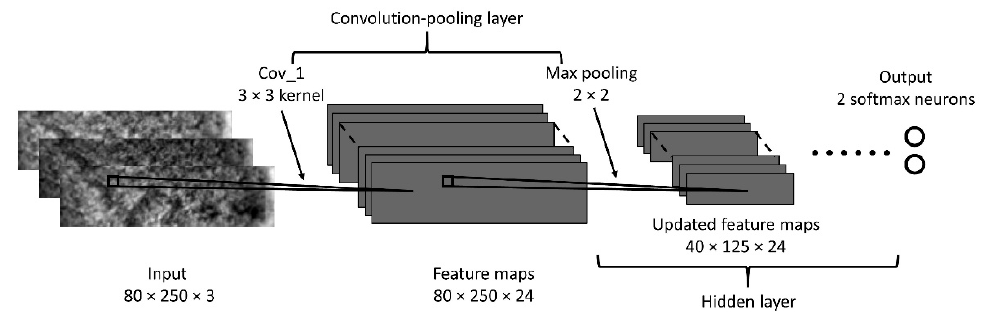
Figure 9. Architecture of a simple convolutional neural network. The input for each sample is a 3-D tensor (height, width, and channel), with channels corresponding to R, G, and B channels. The two output neurons represent two categories (lodging and non-lodging).